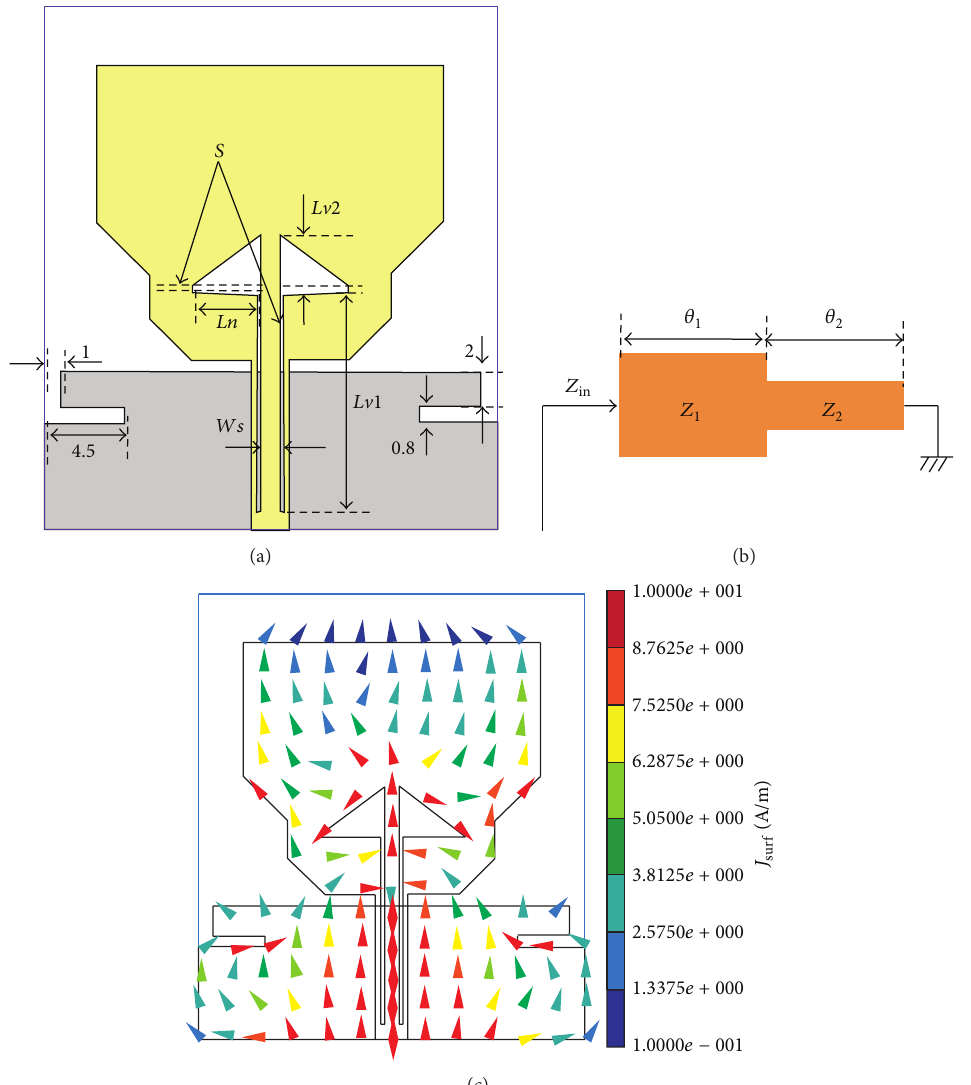
Figure 3: The proposed antenna with the band notch: (a) geometry of the proposed antenna, (b) structure of the SIR, and (c) current distribution at 5.5 GHz.